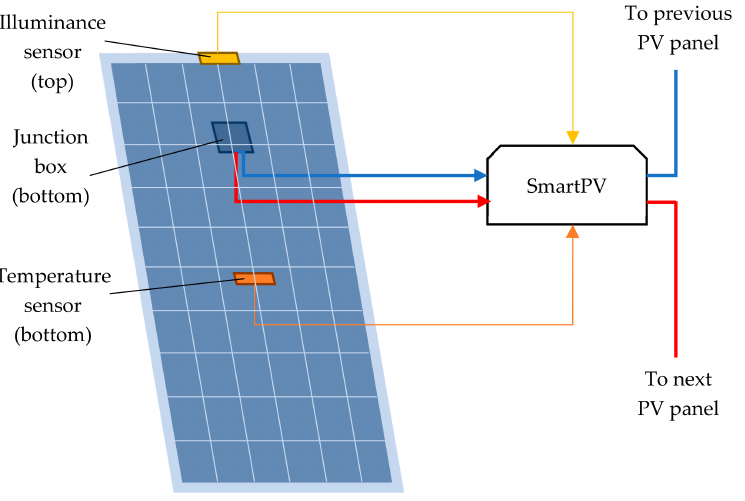
Figure 5. How to connect SmartPV to a PV panel.